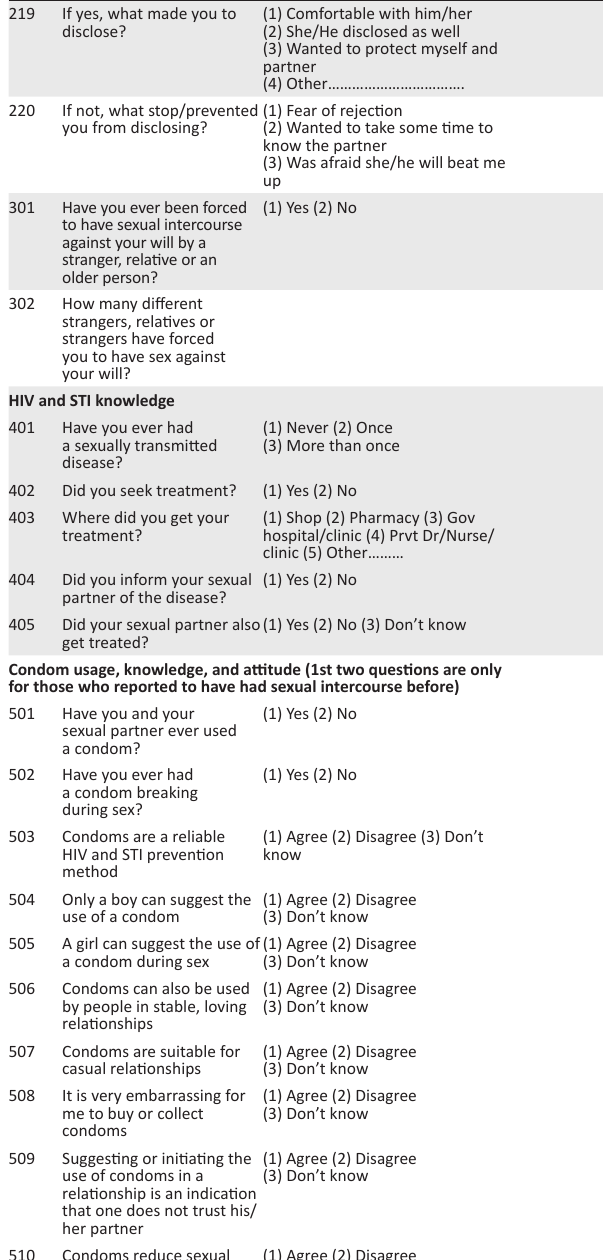
FIGURE 1-A2 (Continues...): Interview questionnaire.